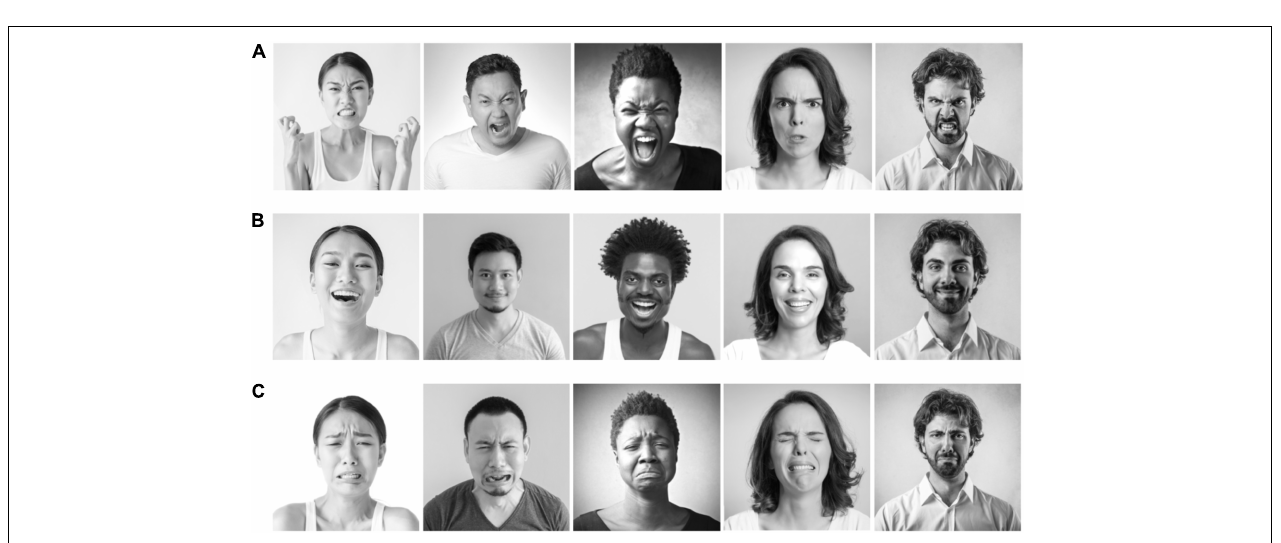
FIGURE 2 | Pictured are examples from the 30 photographs [10 models each depicting anger (A) , smiling (B) , and sadness (C) ] used for our experiment. Standard content license was purchased with signed model release on file at Shutterstock.